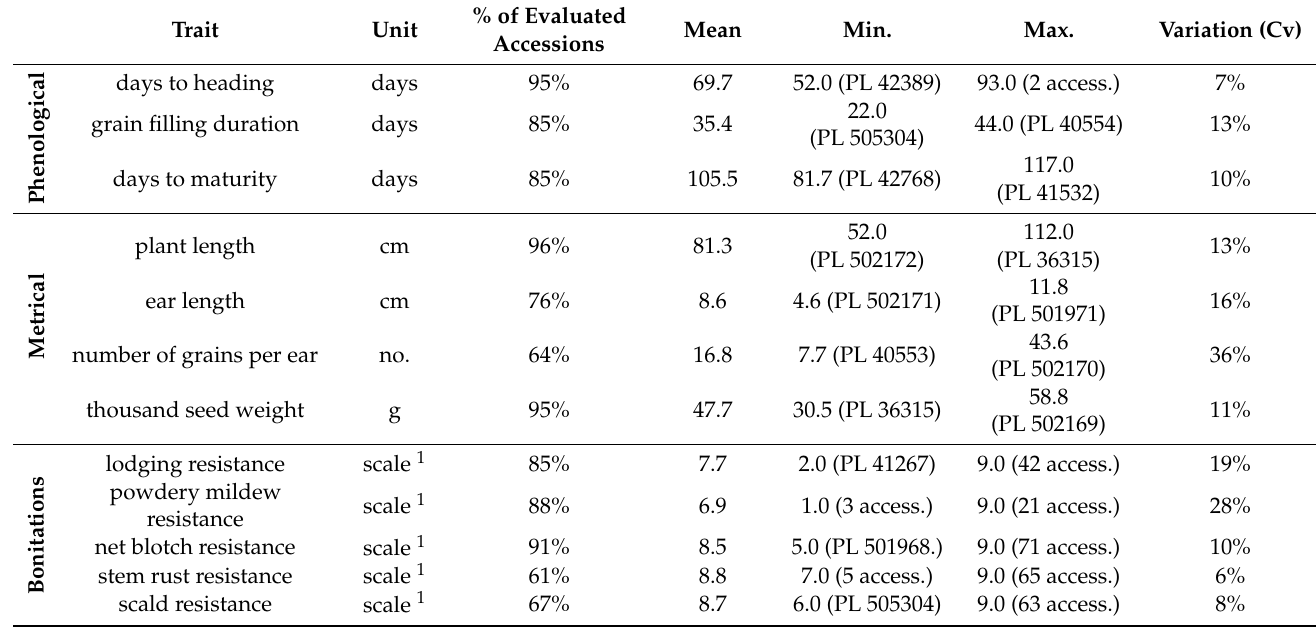
Table 1. Descriptive statistics of average agro-morphological characters based on EGISET database [47]. The accession number is in